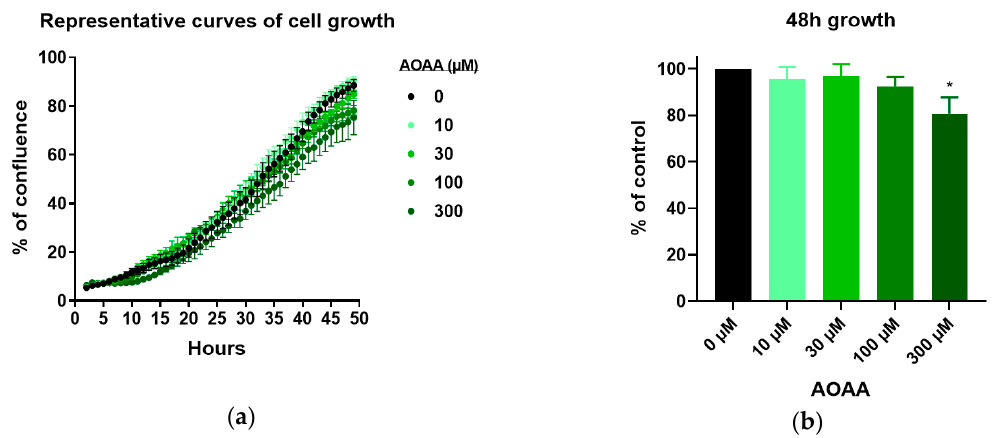
Figure 6. Aminooxyacetate hemihydrochloride (AOAA), (a pharmacological inhibitor of CBS) has minimal effect on CT26 proliferation: ( a ) Confluence of cells untreated or treated with AOAA at very low density was recorded each hour for 48 h. Data are presented as mean ± SEM of three replicates; ( b ) Cell confluence after 48 h growth shown as percentage of untreated cells. Data are presented as mean ± SEM of minimum three independent experiments and Dunnett’s multiple comparisons tests are shown vs. 0 µM (* p < 0.05).